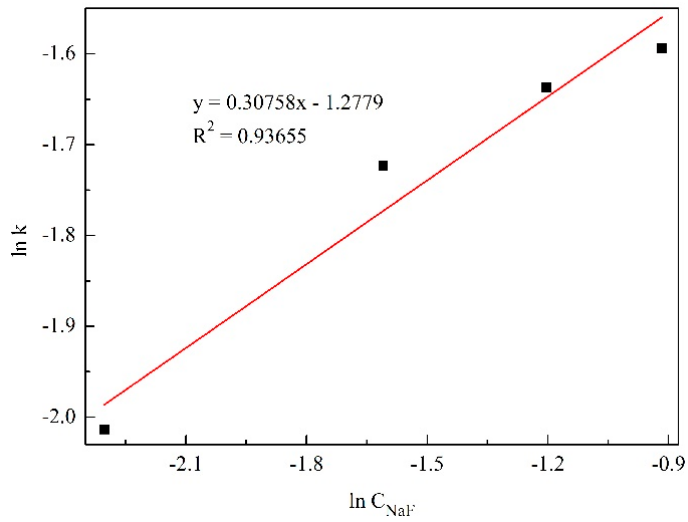
Figure 17. Plot of lnk vs. lnC NaF in alkali fused SCC leaching process.